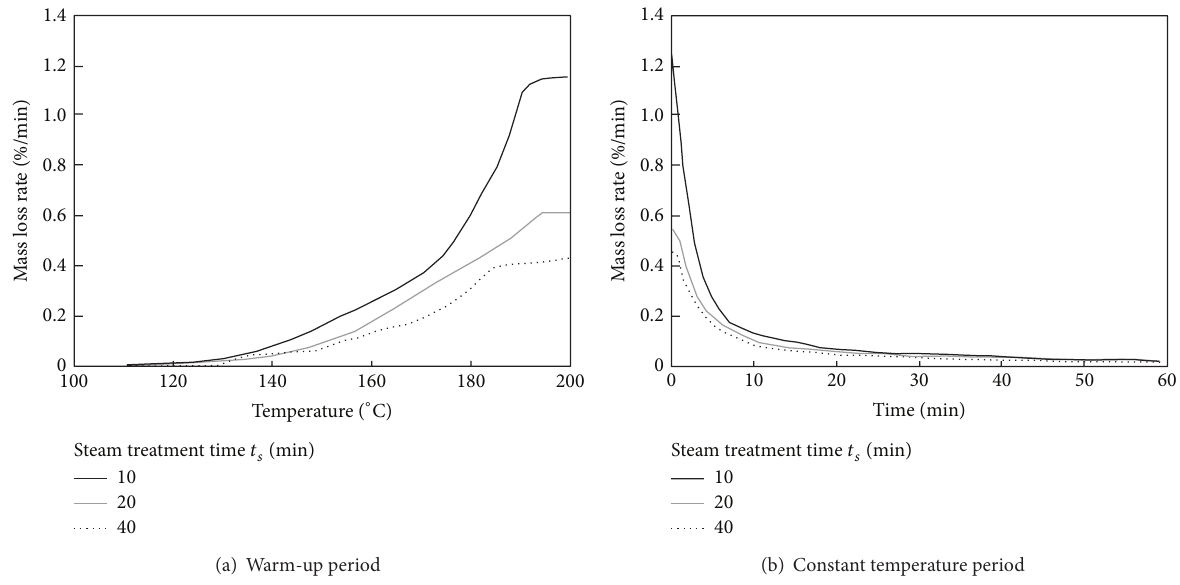
Figure 9: Mass loss rate for steam treated bamboo powder with a variable steam treatment time 𝑡 𝑠 . ( 𝑇 𝑠 = 200 ∘ C)